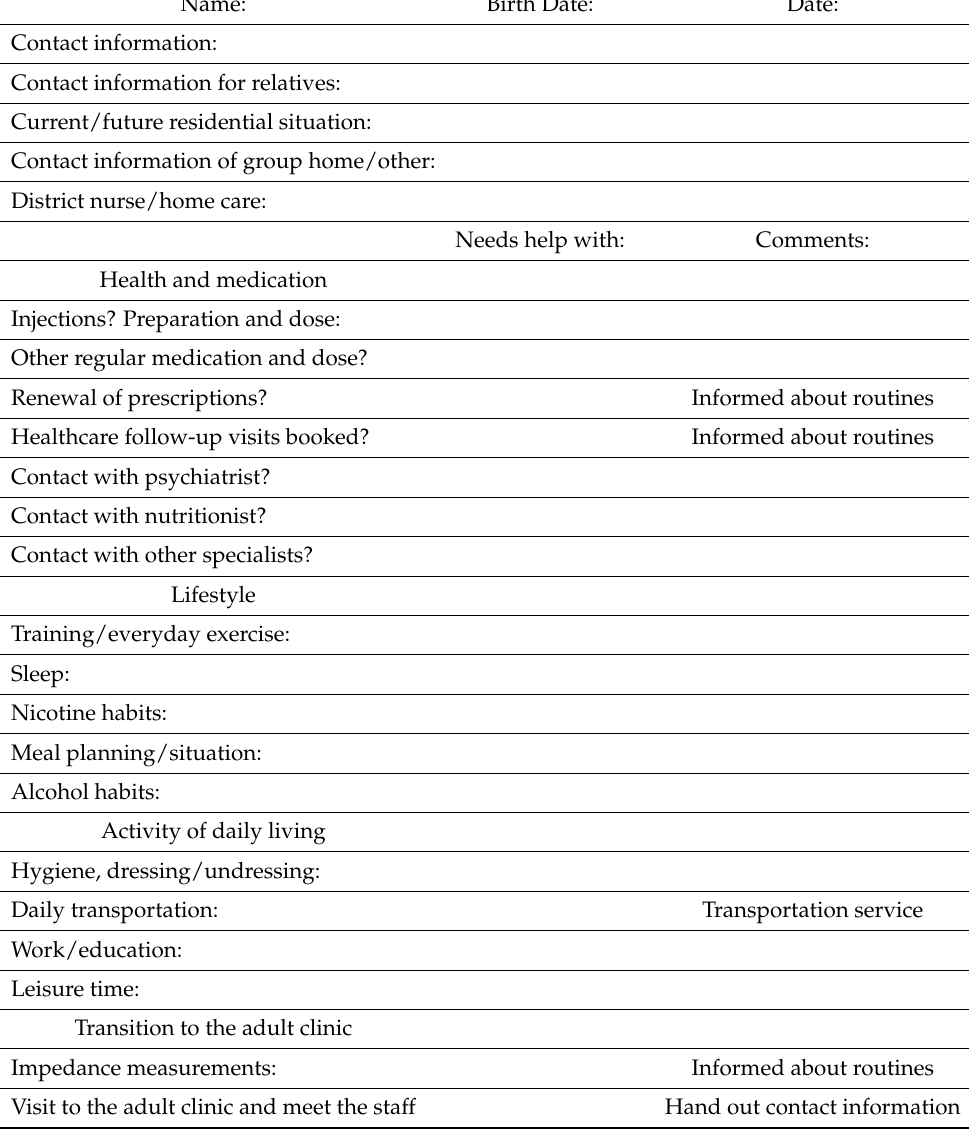
Table 1. Checklist for transition from pediatric to adult care of young adults with Prader–Willi